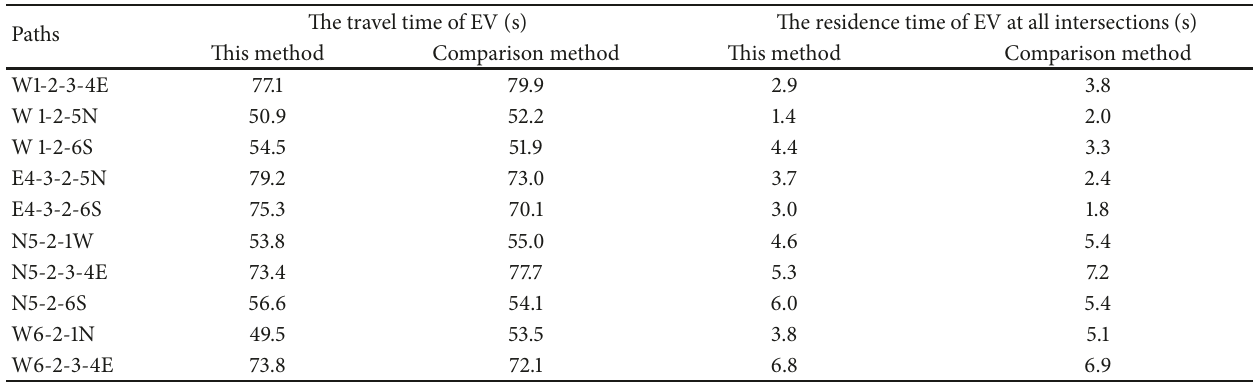
Table 2: Comparison of simulation